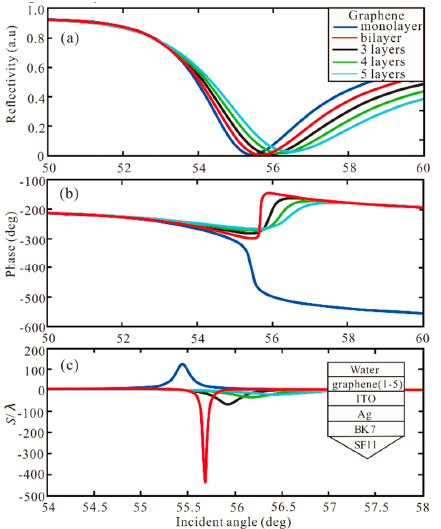
Figure 2. ( a ) Reflectivity and phase, and ( b ) GH shift for Ag and Ag-ITO structure with incident angle. Although ITO plays a certain role in the increase of GH shift, the enhancement is still relatively small. Next, we study the influence of the graphene layer, as shown in Figure 3. For the graphene monolayer, the reflectivity is 0.0024 a.u at 55.44° and the GH shift is 125.7 λ . When the graphene bilayer is added to the Ag-ITO structure, the best performance is obtained with the largest GH shift of − 439.7 λ . We can observe that the phase change from Z-shaped-like to Lorentzian-like, and GH shift change from positive to negative. Then , with the increase of graphene layers, the GH shift is